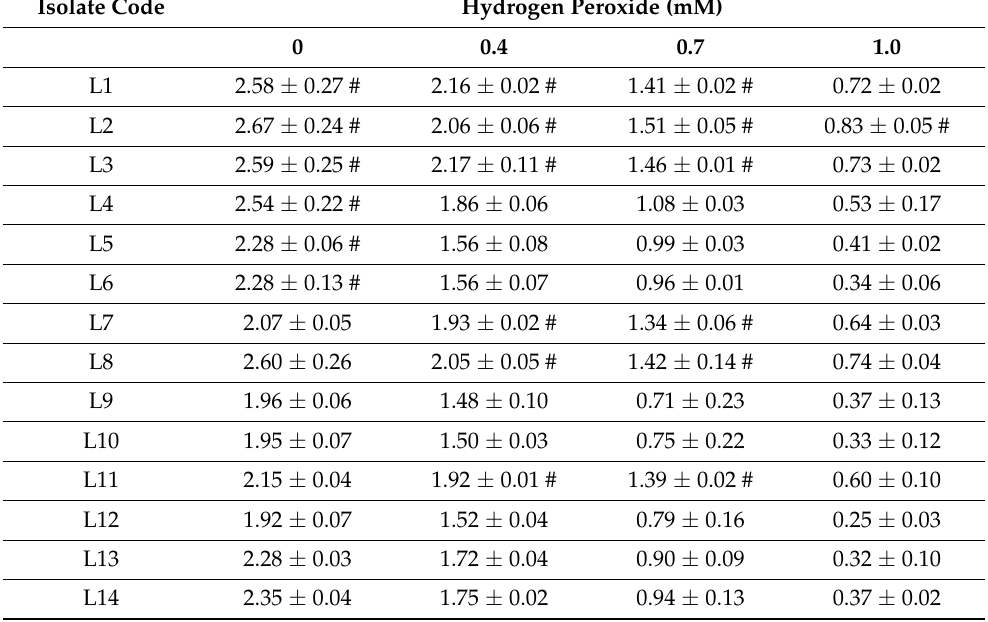
Table 4. Resistance of Leuconostoc mesenteroides subsp. mesenteroides strains to different concentrations of hydrogen